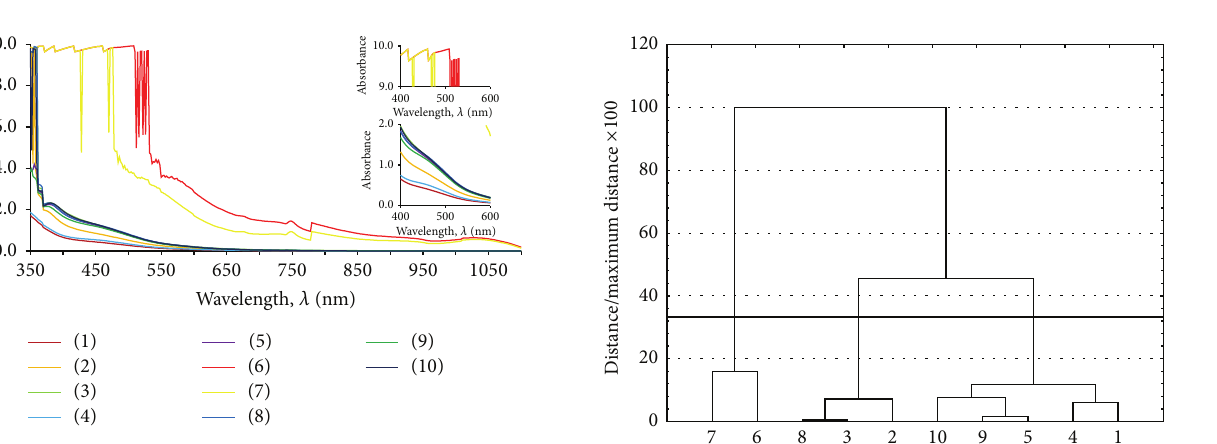
Figure 1: Set of UV-Vis spectra of dog rose extracts.